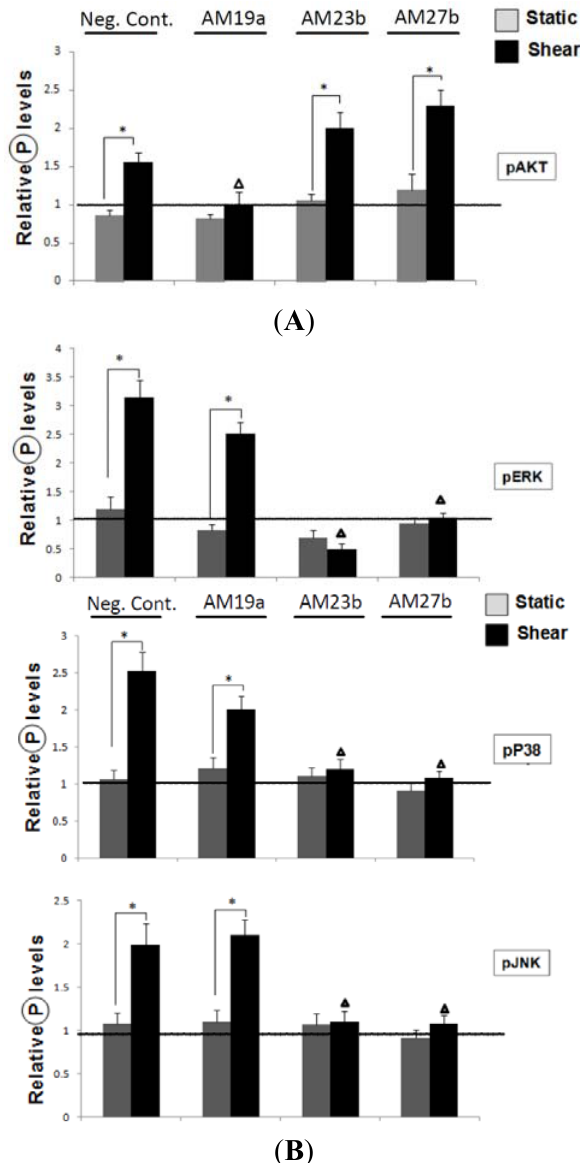
Figure 3. Inhibition of miRs in shear-regulation of AKT and MAPK. ( A ) Antagomir against miR-19a decreased the shear-induced PI3K activation, but had no effect on MAPK activation; ( B ) Antagomir against miR-23b, 27b decreased the shear-induced MAPK activation, but had no effect on PI3K activation. Data are presented as the mean ± SEM (n = 3) (Data were normalized to the control in Neg Cont. group). * p < 0.05 (Compared with the Static); in pAKT assay, ∆ p < 0.05 (Compared with the shear groups in Neg Cont., AM23b and AM27b groups; in pERK, pP38, pJNK assay, ∆ p < 0.05 (Compared with the shear groups in Neg Cont. and AM19a